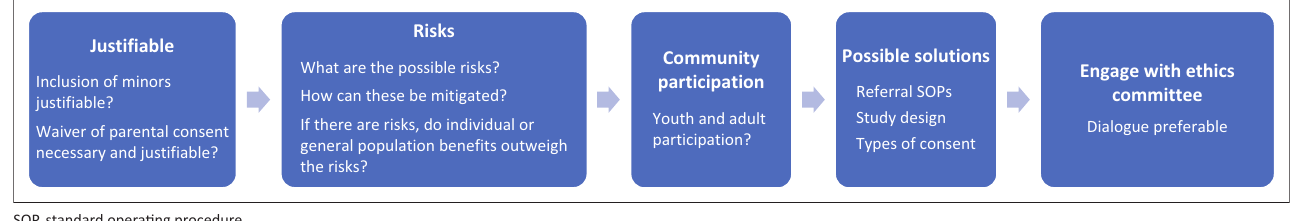
Justifiable Inclusion of minors